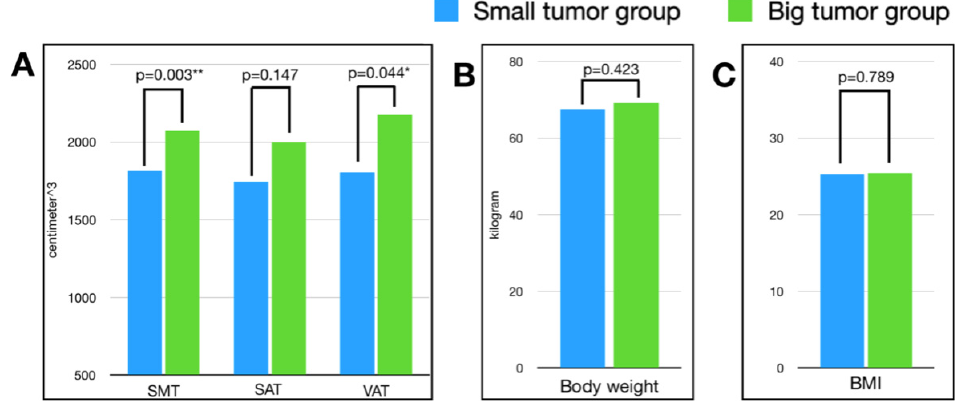
Figure 3. Comparison of body composition factors, body weight, and BMI in tumor size subgroup analysis in localized RCC. ( A ) SMT, SAT, and VAT; ( B ) body weight; and ( C ) BMI. * p- value < 0.05; ** p- value < 0.01.